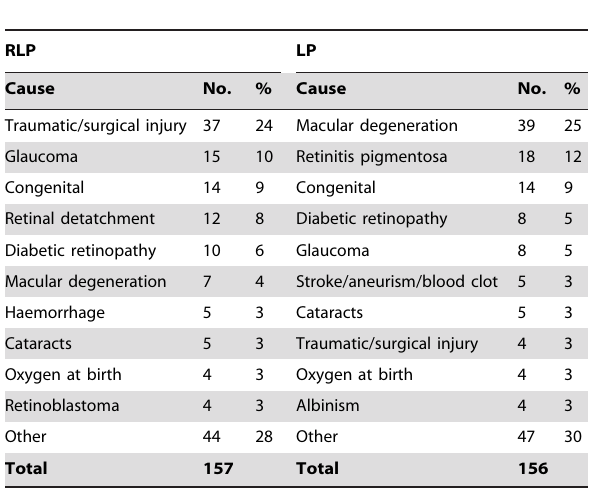
Table indicating the ten most common causes of blindness/visual impairment in the two main groups surveyed (RLP – reduced conscious light perception and LP – conscious light perception in both eyes).